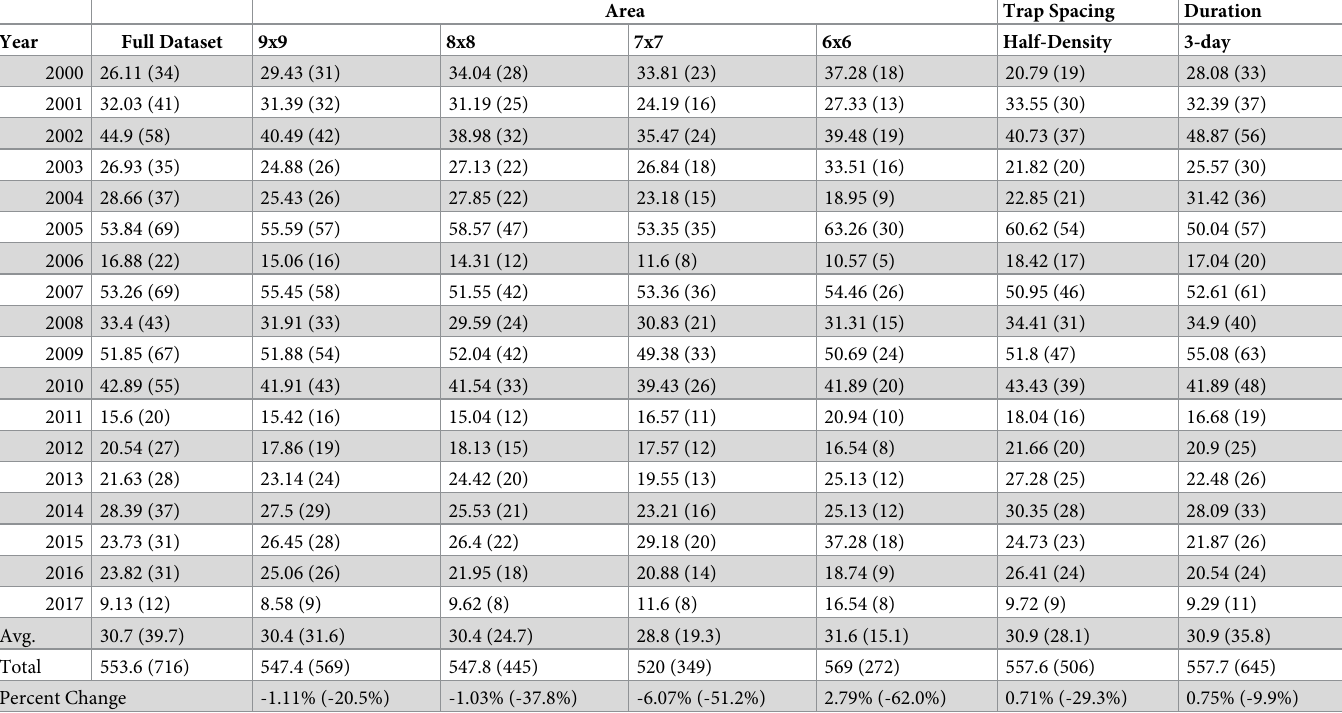
Table 1. Salt marsh harvest mouse density estimates (mice/ha) and capture numbers [D(capture)] for the full dataset and subsampled datasets between 2000 and